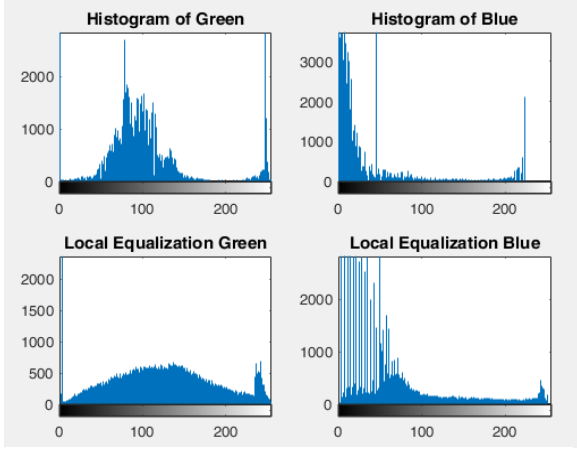
Figure 3. Before/after histogram equalizations of the left image As the histograms of Green and Blue channels intensify certain values to narrow ranges, some object features in the images were lost. After local adaptive histogram equalization was applied to poor distributed channels, hidden features were made more visible. Moreover, abrupt contrast changes occurred in the images were compensated partially. Figure 5a and 5b shows results of the enhanced left and right images, respectively.